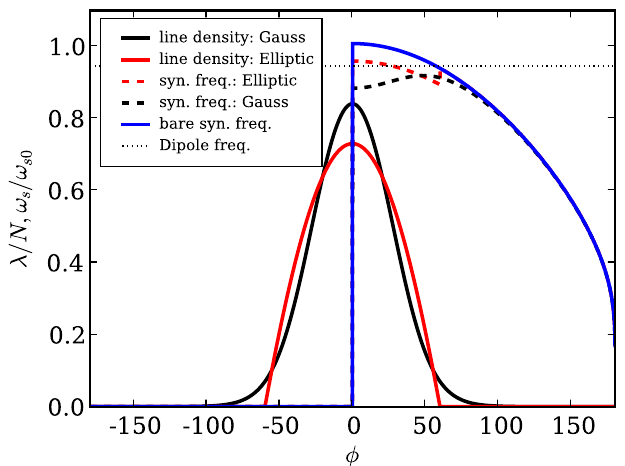
FIG. 1. (Color) Matched line densities for (cid:1) (cid:7) 0 : 1 and bunch (cid:7) 60 (cid:12) in the case of equivalent matched elliptic and length (cid:1) m Gaussian bunch distributions in a single rf wave. The dashed curves correspond to the respective synchrotron frequencies. The horizontal line represents the dipole frequency.